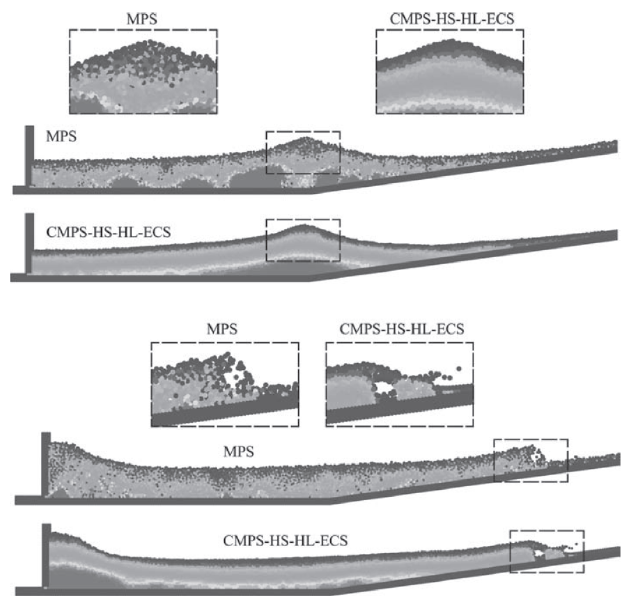
Fig. 6: Comparison between standard MPS and CMPS-HS- HL-ECS through breaking waves test case